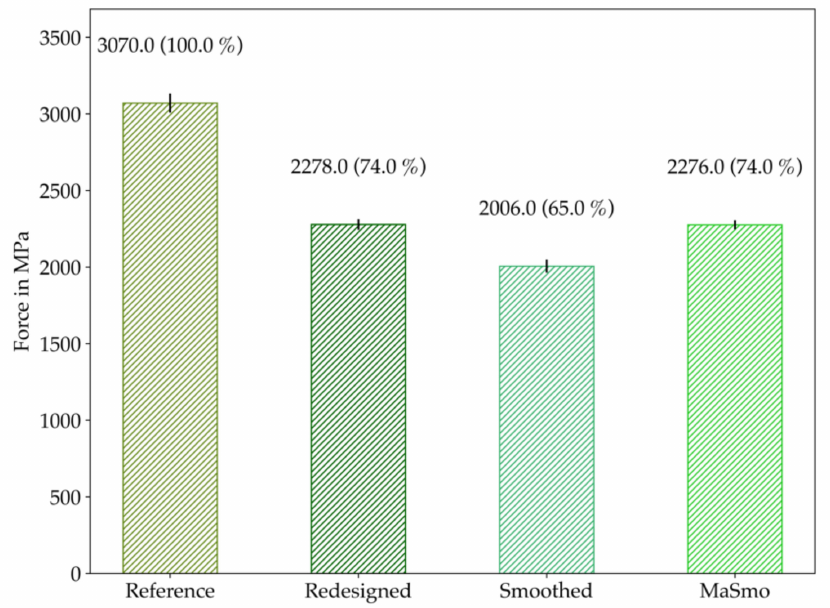
Figure 18. Comparison of the maximum forces. The mean values are plotted together with the standard deviation. The difference from the reference is written in brackets in percent. The displacements are evaluated in detail in Figures 19 and 20.